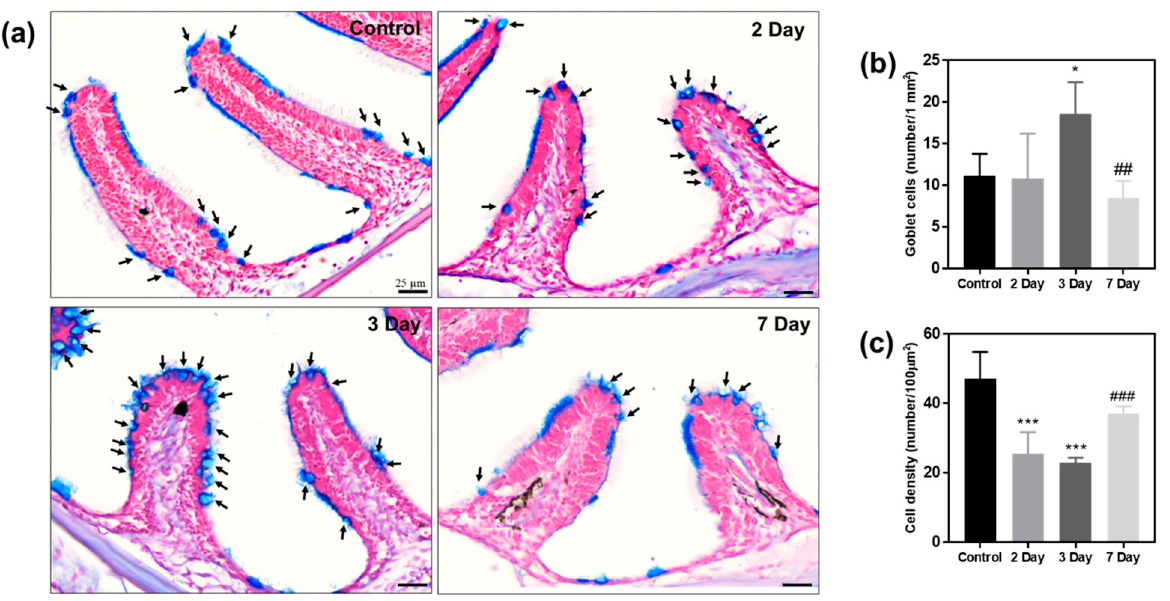
Figure 6. Histopathology analysis of zebrafish olfactory organs using Alcian blue and nuclear red fast red staining. ( a ) Images of control, damage group (2 and 3 days) and recovery group (7 days), scale bar = 25 µm. To analyze the damage to olfactory organs, the number of goblet cells and the cell density were quantified using Image J 1.52a software. ( b ) Number of goblet cell per 1 mm 2 . ( c ) Cell density analysis per 100 µm 2 . Values are reported as mean ± SEM of five distinct olfactory samples. Statistical analysis by one-way ANOVA, * p < 0.05, *** p < 0.001 versus control; ## p < 0.01, ### p < 0.001 versus three-days.